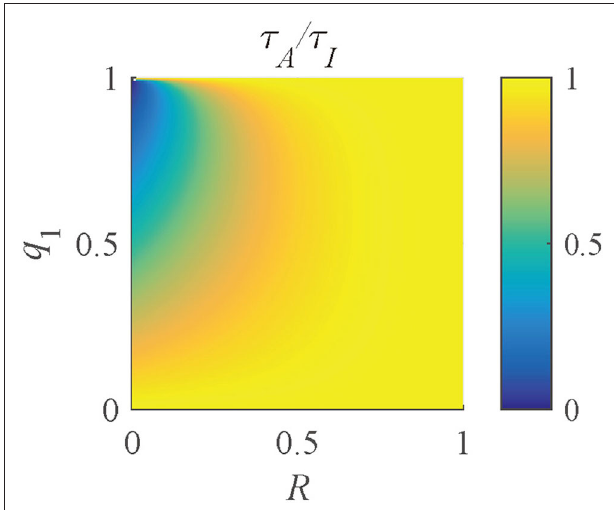
FIGURE 8 | Distribution of τ A /τ I with q 1 = 0